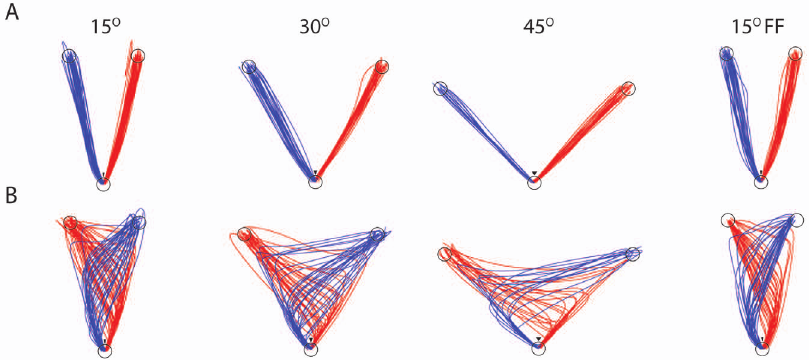
Figure 3. A: Sample hand trajectories from Subject 2 for the four conditions (3 different angular target separations and force field FF). Most trajectories extend directly from the home position (bottom circle) to one of the choice targets. B: In a fraction of trials, the trajectories change course during the movement, indicating a change of mind. Panel B shows all the change of mind trials for this subject and in panel A and equal number of non change-of-mind trials have been randomly selected. Note the visual/haptic wedge just above the home position which subjects were not allowed to contact.